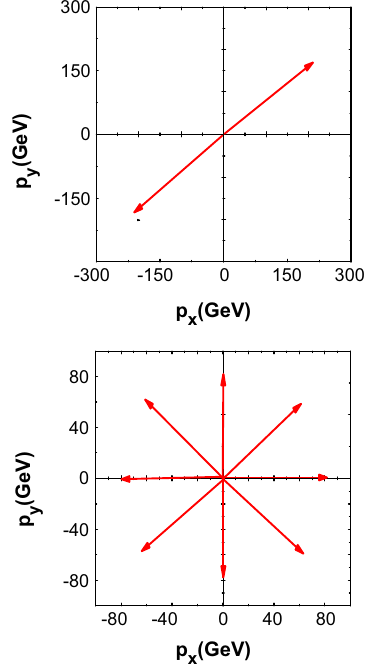
Fig. 1 Top: typical pencil-like selected event with S ⊥ = 0; bottom: typical Sphere-like selected event with S ⊥ = 1